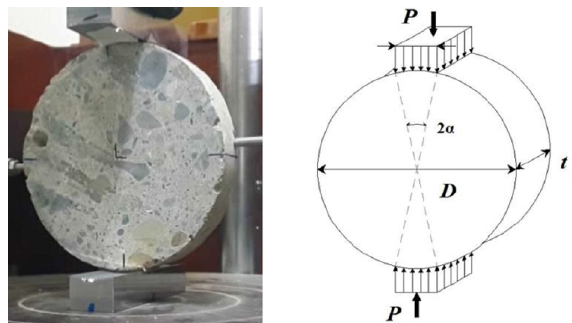
Figure 3. Experimental setup for the Brazilian